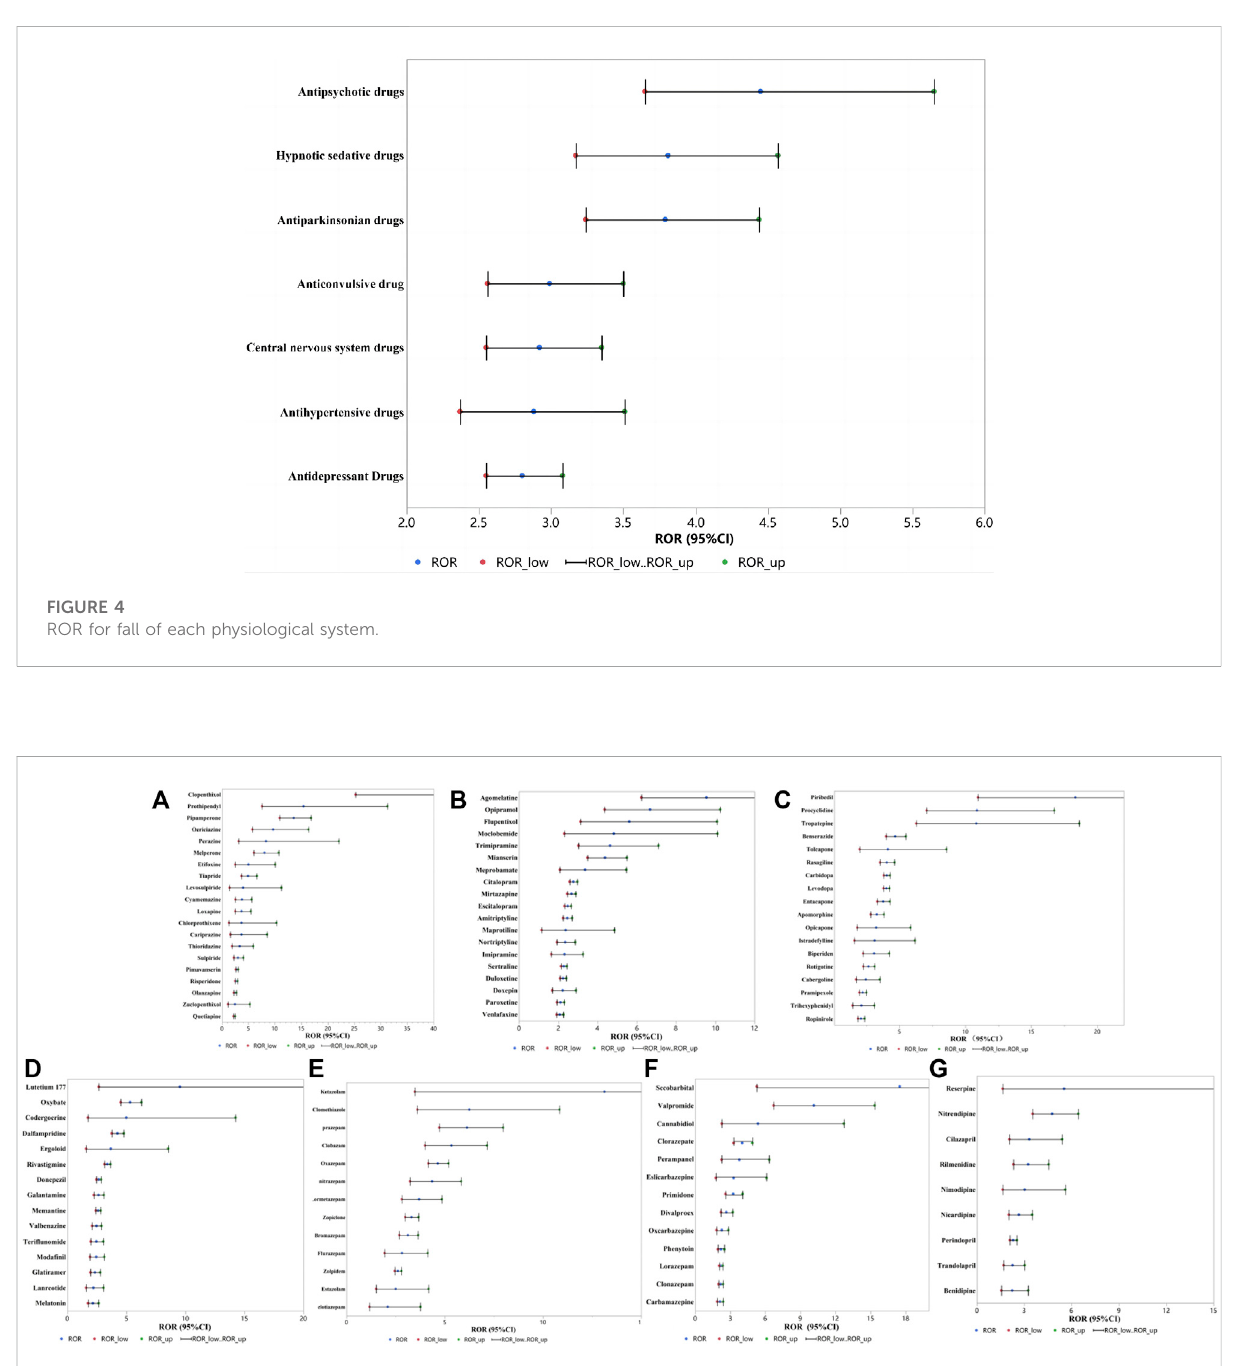
FIGURE 5 RORs for fall with positive signals detected drugs (A) antipsychotic drugs, (B) antidepressant drugs, (C) antiparkinsonian drugs, (D) central nervous system drugs, (E) hypnotic sedative drugs, (F) anticonvulsive drug, (G) antihypertensive